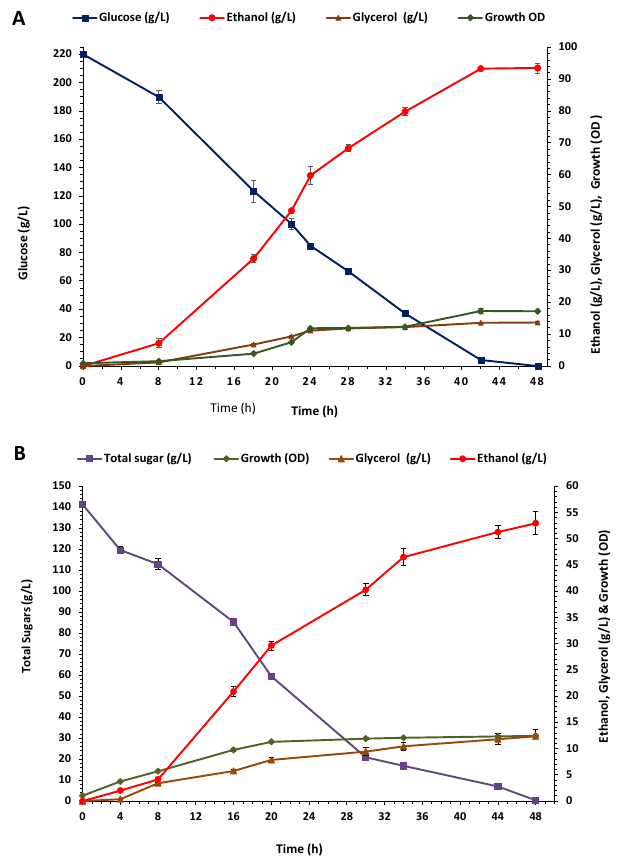
Figure 5. Changes in the concentration of glucose, ethanol, glycerol and biomass in fermentations conducted in 15 L bioreactor using SW-based medium and the marine strain S. cerevisiae AZ65. ( A ) SW-YPD medium; ( B ) SW-Molasses medium. The experimental error bars represent the standard deviation of the three replicates.